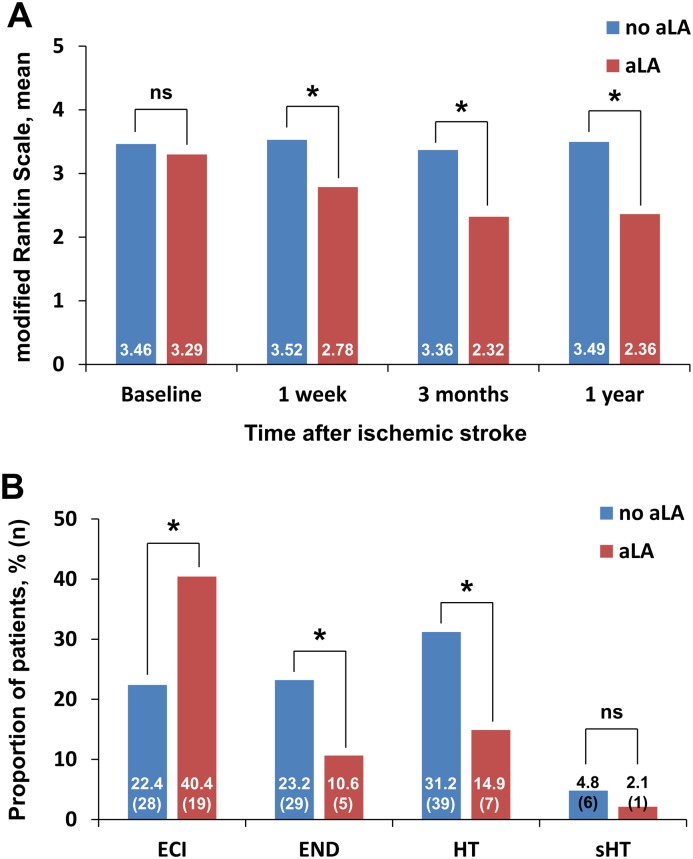
(A) Changes from baseline modified Rankin Scale (mRS) up to 1 year after stroke. (B) Proportion of patients with early clinical outcomes and hemorrhagic transformation displayed according to the use of alpha-lipoic acid (aLA). *p < 0.01 vs. no-aLA group; the chi-square test was used to compare proportions. ECI = early clinical improvement; END = early neurological deterioration; HT = hemorrhagic transformation; sHT = symptomatic hemorrhagic transformation.